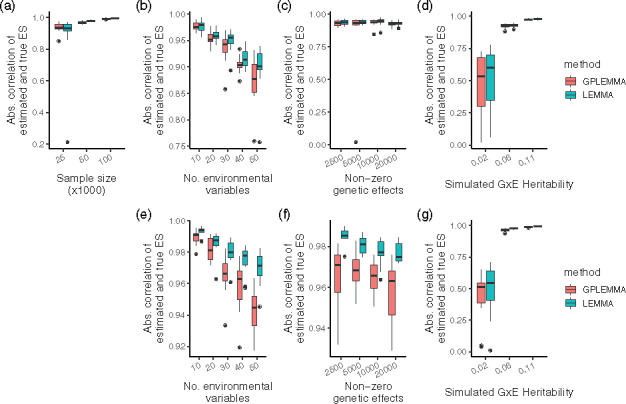
Correlation between the true ES and the inferred ES. Absolute correlation between the true ES and the ES inferred by LEMMA and GPLEMMA whilst varying the number of environments, the number of active environments, the number of non-zero SNP effects and GxE heritability. All simulations constructed with the baseline phenotype. a–d Simulations results using N=25K samples and M=100K variants by default, e–g simulation results using N=100K samples and M=300K variants. Results from 15 repeats shown